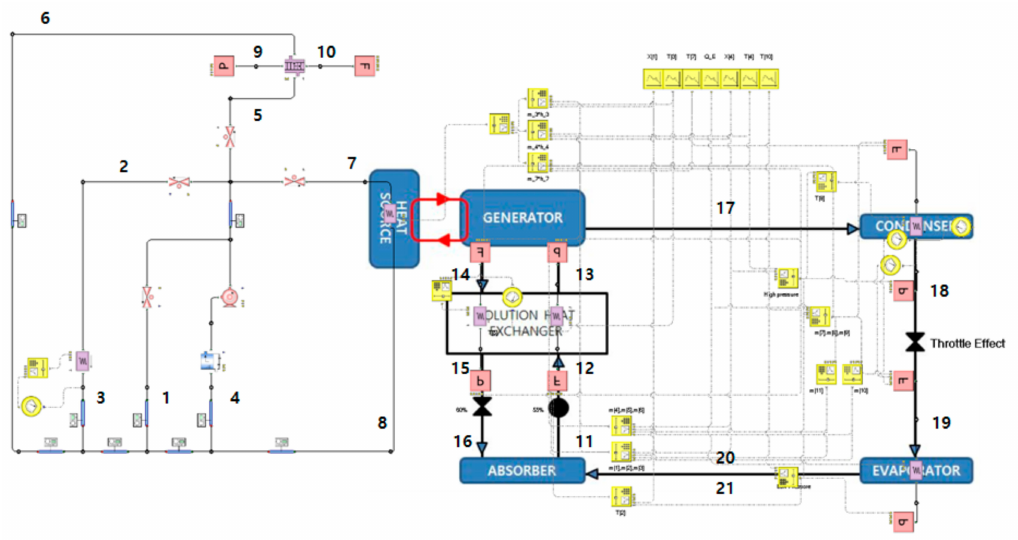
Figure 2. Simulation design of tri-generative system using FloMaster.